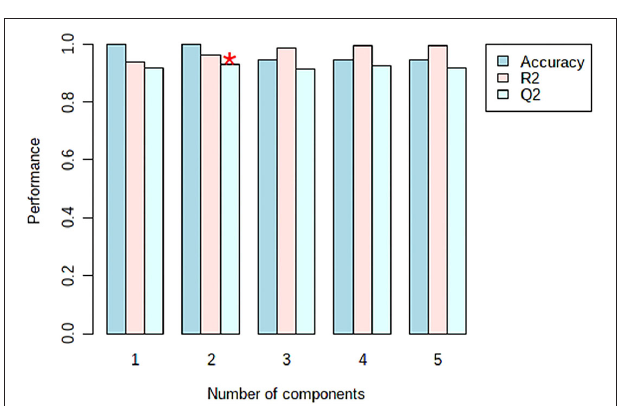
FIGURE 7 | Cross validation parameters of the developed PLS-PDA model with the prediction error measure: accuracy, R2, Q2 (The accuracy = 1.0, was obtained from the second component shown with